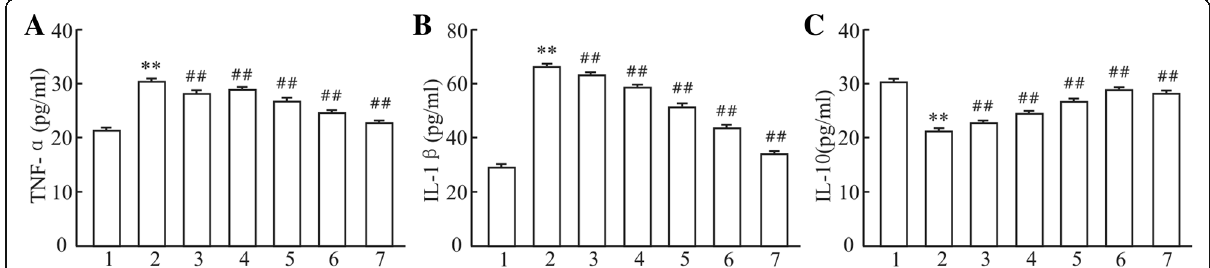
Fig. 2 Effects of polysaccharide extract from XJEK on TNF- α , IL-1 β and IL-10 of HUVECs induced by Ang II. ( a ) TNF- α level in supernatants of HUVECs; ( b ) IL-1 β level in supernatants of HUVECs; ( c ) IL-10 level in supernatants of HUVECs. 1, blank control group; 2, Ang II (10 − 5 mol/L) group; 3, Ang II (10 − 5 mol/L) + AqE (0.15 mg/ml) group; 4, Ang II (10 − 5 mol/L) + AqE (0.3 mg/ml) group; 5, Ang II (10 − 5 mol/L) + AqE (0.6 mg/ml) group; 6, Ang II (10 − 5 mol/L) + AqE (1.2 mg/ml) group; 7, Ang II (10 − 5 mol/L) + XJEK (1.6 mg/ml) group. Data are expressed as mean ± SD, n = 6. ** P < 0.01 vs control group; ## P < 0.01 vs Ang II